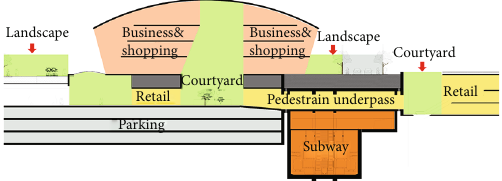
Figure 4: Stereoscopic walking system (source: self-created per the relevant information).